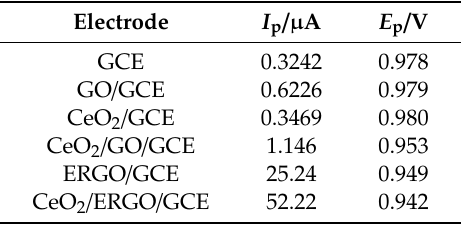
Table 1. Detailed data of CVs of 10 µ M vanillin recorded at di ff erent